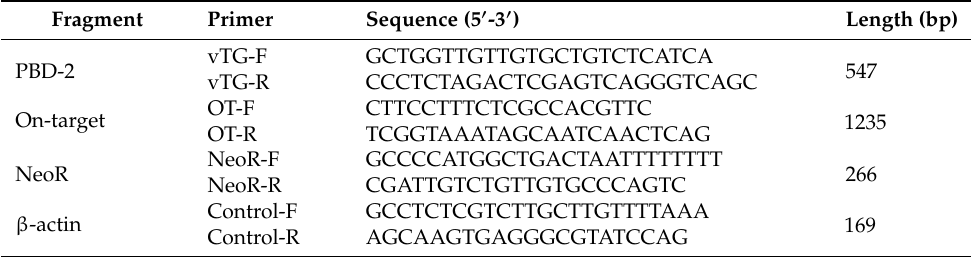
Table 1. Information of primer pairs for genotype analysis of cloned